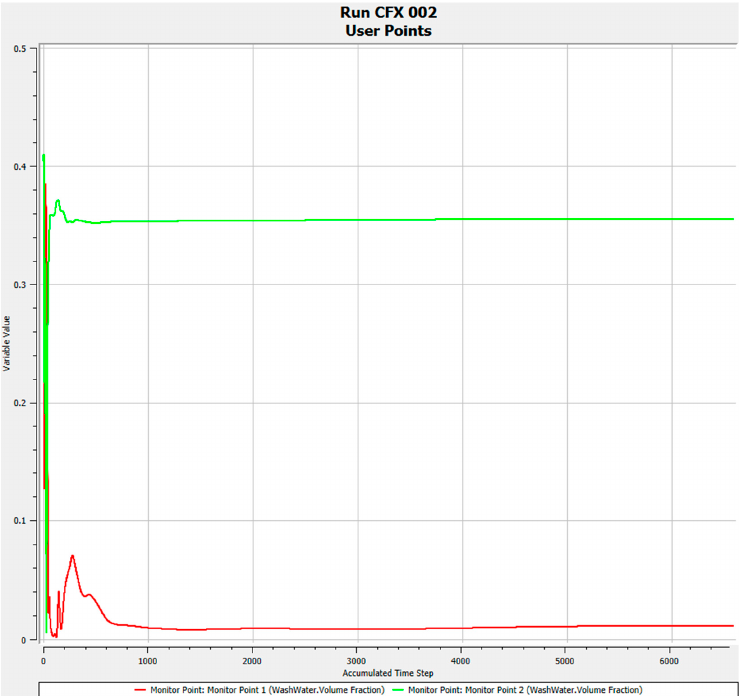
Table 4. Load case parameters.